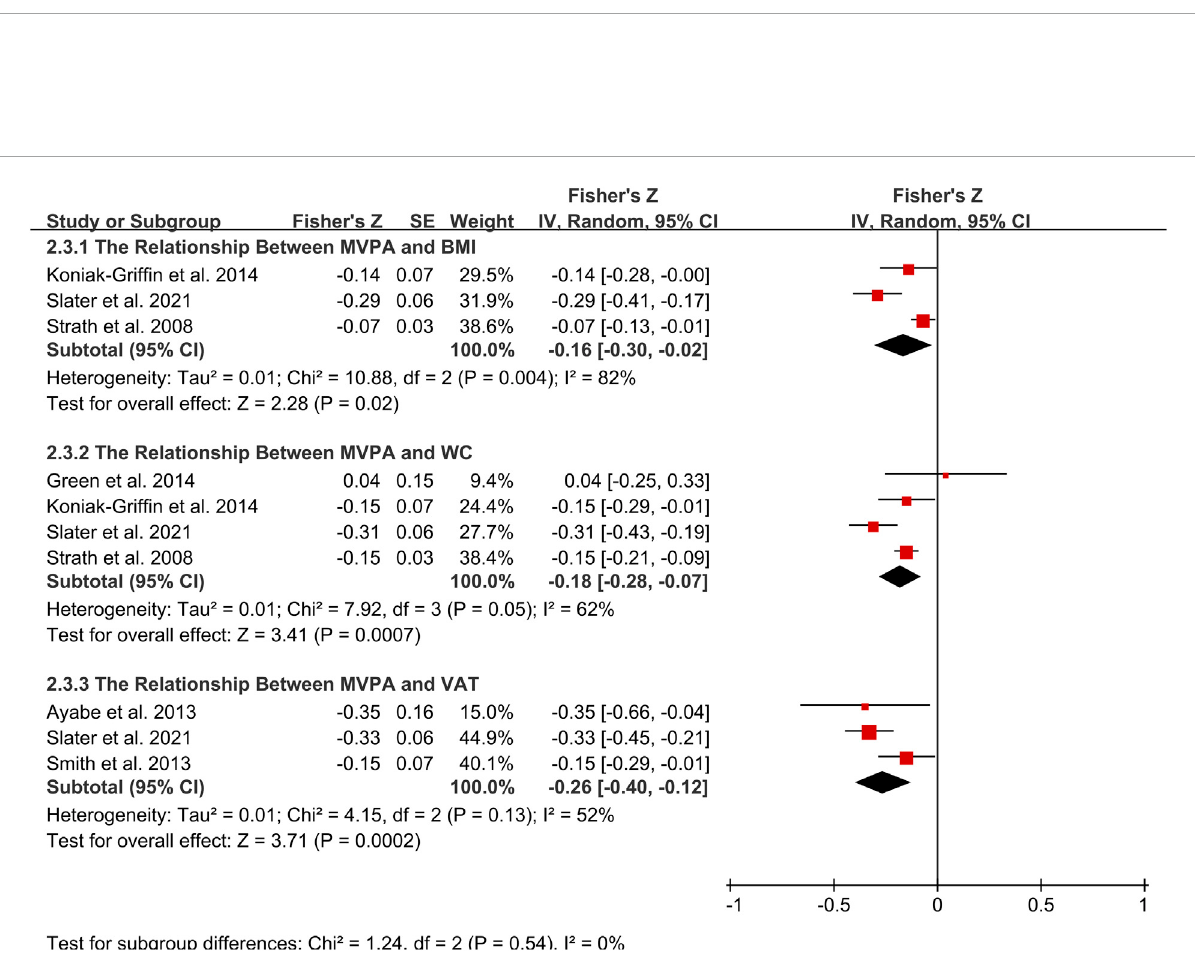
Forest plot of correlation between MVPA and adiposity outcomes. Overall pooled correlation for random effects model represented by black diamond. Note: BMI, body mass index; MVPA, moderate to vigorous physical activity; VAT, visceral adiposity tissue; WC, waist